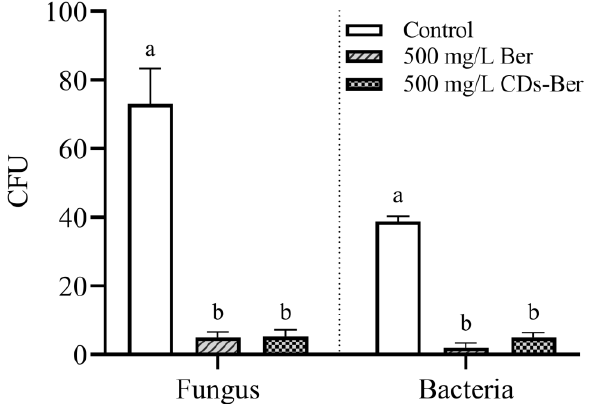
Figure 8. Effects of berberine and CDs-Ber treatments on fungi and bacteria in soil (concentration of berberine and CDs-Ber is 500 mg/L; control is deionized water). Note: data are presented as mean ± SD ( n = 4). Comparison within the group, different letters indicate significant differences, the same letter indicates no significant difference ( p < 0.05, LSD